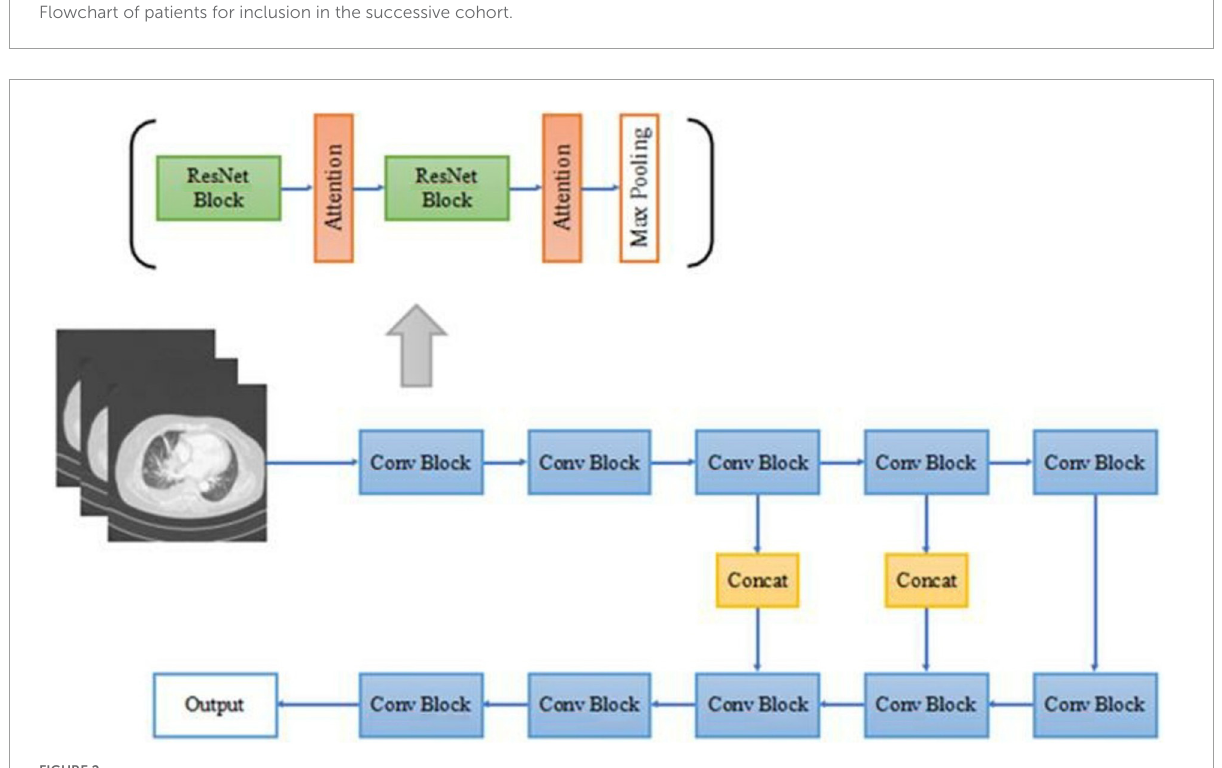
FIGURE2 The architecture of our proposed 3D convolutional neural network